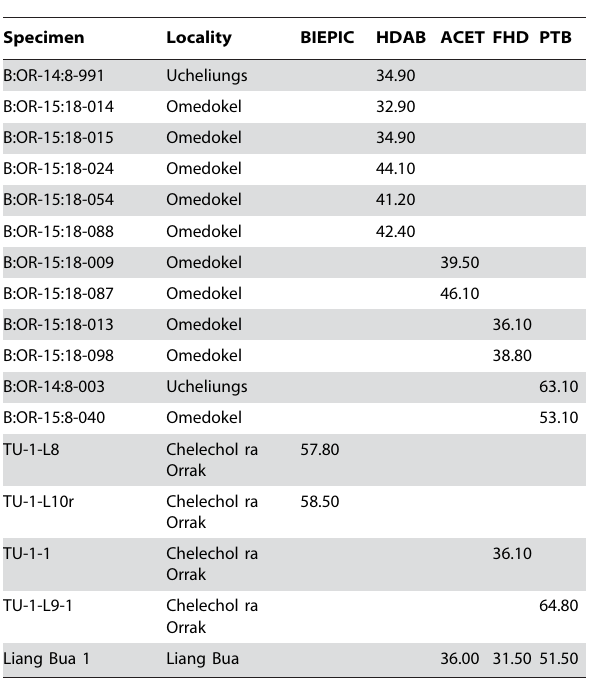
Table 1. Skeletal inventory from Palau used in the